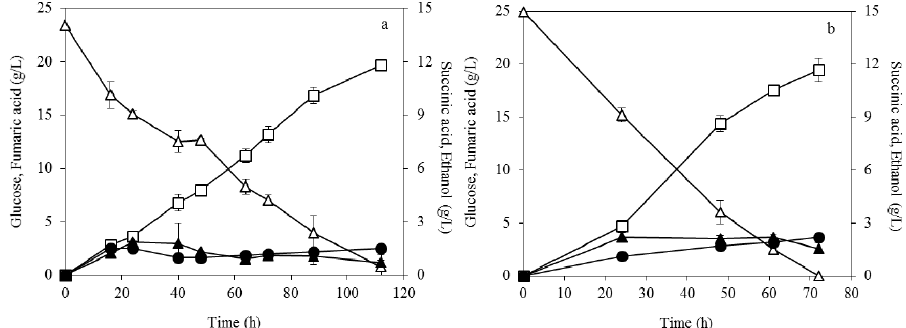
Figure 3. Effect of dispersed mycelia morphology on fumaric acid ( □ ), ethanol ( ▲ ) and succinic acid ( ● ) production during submerged fermentation of R. arrhizus NRRL 2582 at 25 g/L initial glucose concentration ( (cid:52) ). The initial ammonium sulphate concentration was ( a ) 0.04 g/L and ( b ) 0.2 g/L.